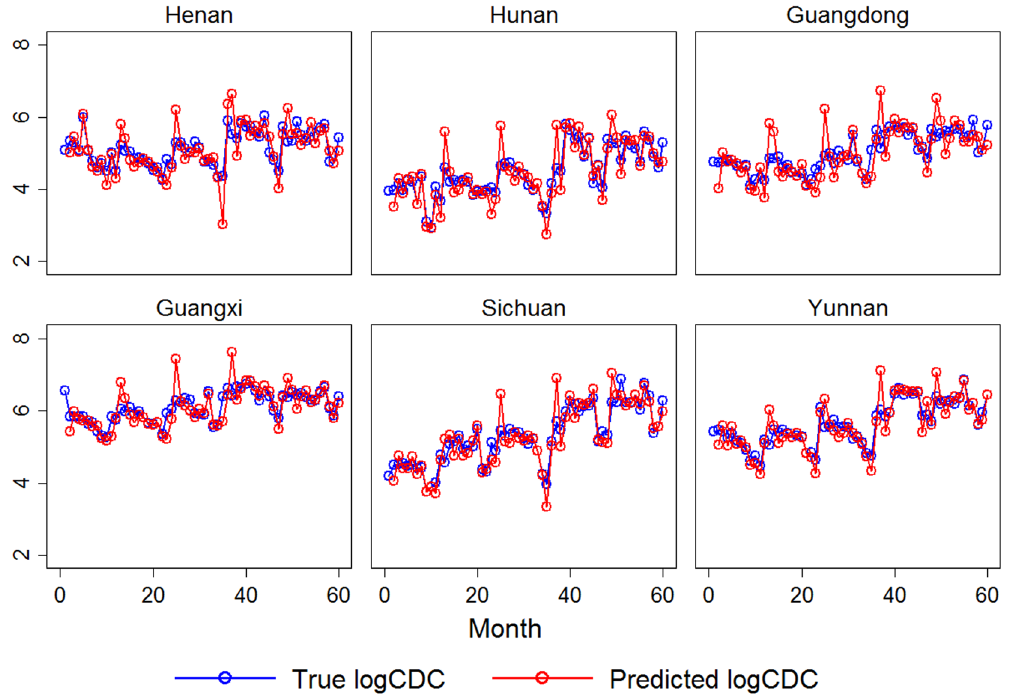
Figure 4. True and predicted logCDC in six provinces with high HIV/AIDS concentration, using the PMG